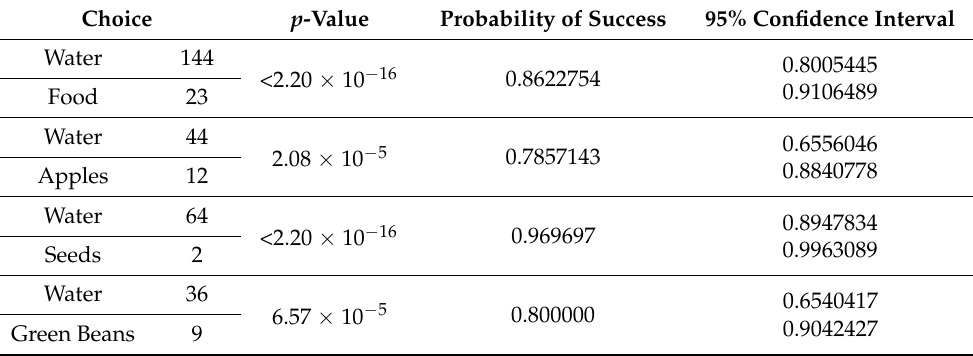
Table 1. Choice counts between water vs. food (apple, seed, green bean) and p -value of the binomial test.